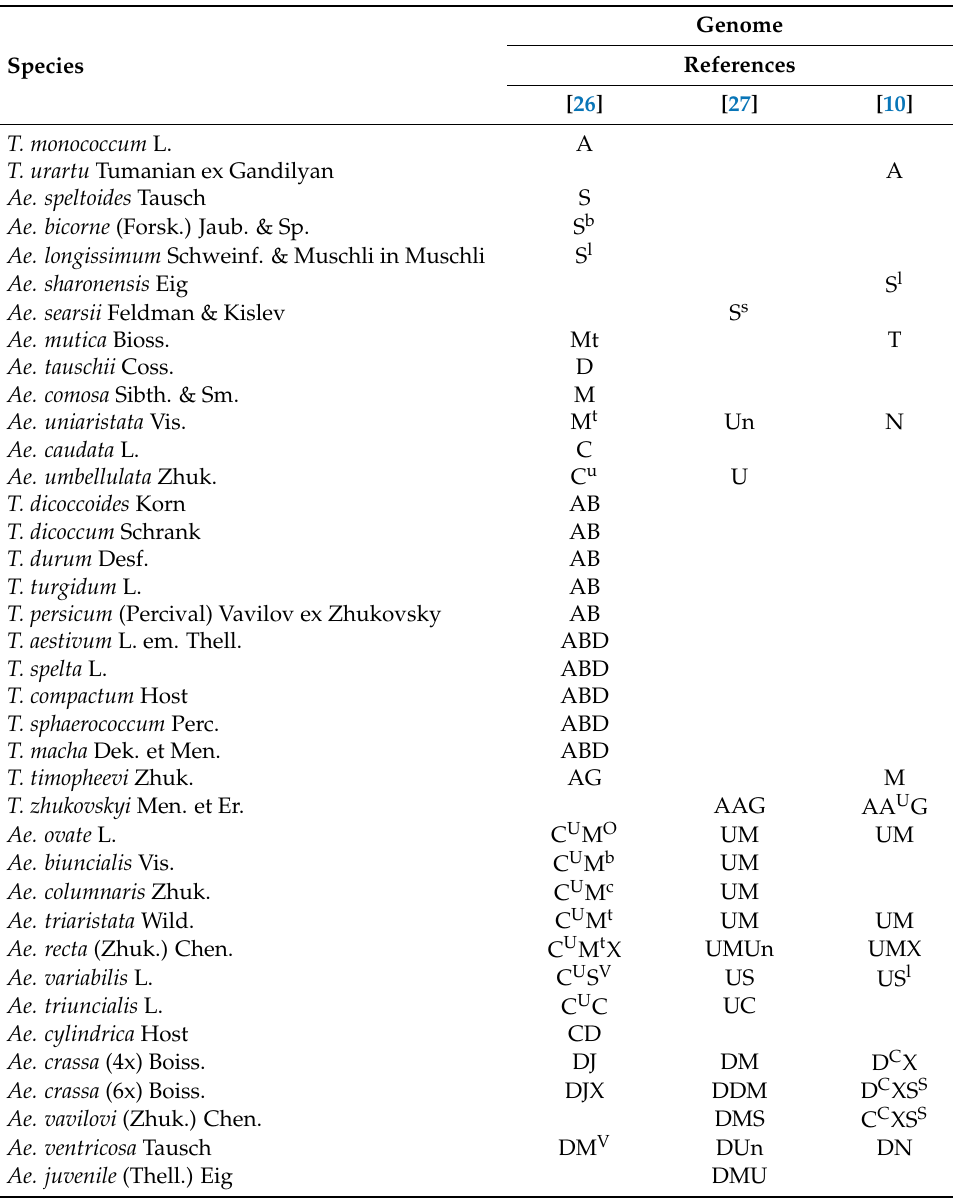
Table 2. List of different Aegilops and Triticum species along with their genomic constitutions.